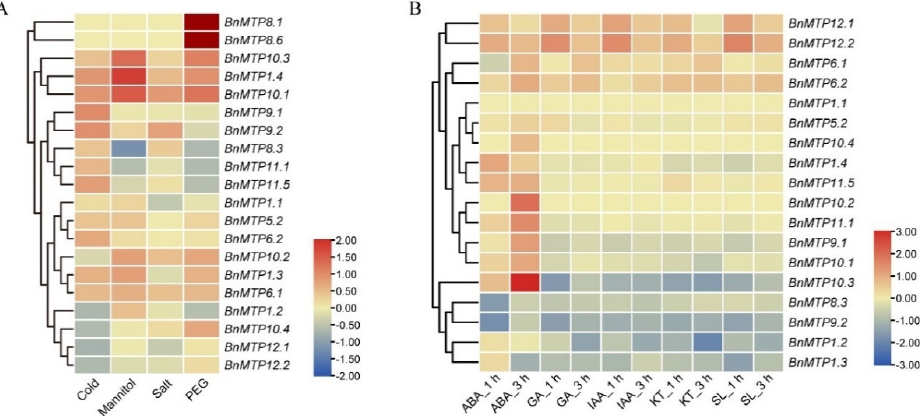
Figure 10. BnMTP genes in response to abiotic stresses and hormone treatments. ( A ) Gene expression under abiotic stress. ( B ) Gene expression under hormone treatment. Ratios of FPKM values under stress conditions to FPKM values under normal conditions were log 2 transformed and used to represent the gene expression levels.